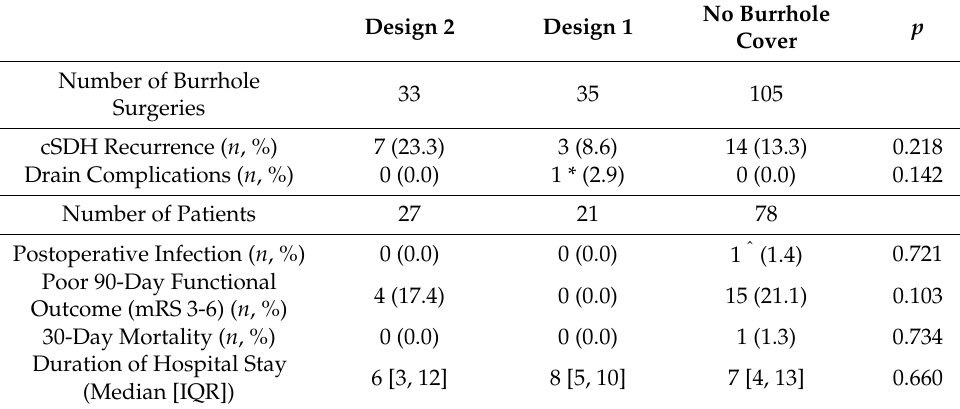
Table 6. Clinical safety outcome